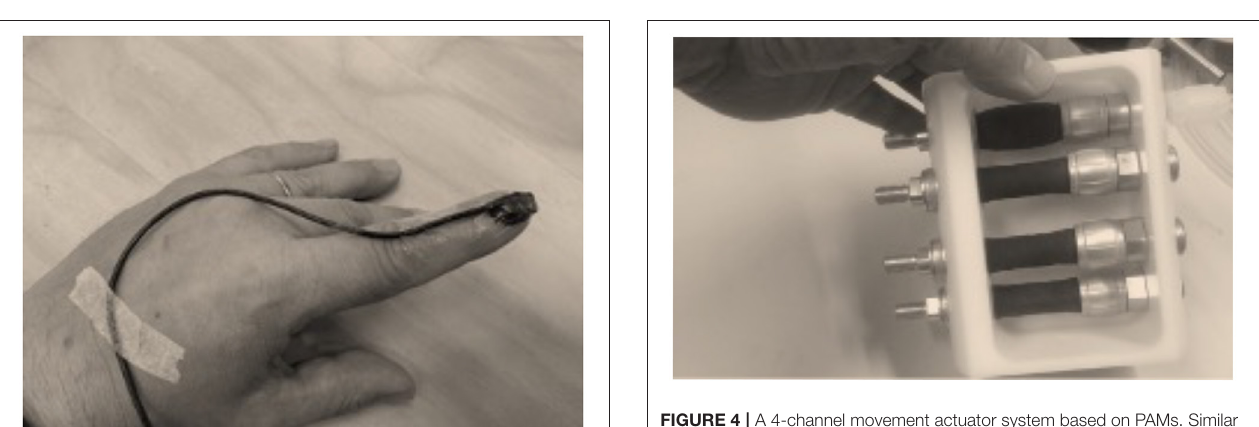
FIGURE 4 | A 4-channel movement actuator system based on PAMs. Similar PAMs were used in studies using computer-controlled PAM stimulator. Note that the uppermost artificial muscle is contracting due to compressed air pulse applied on the muscle and the muscle is relaxed when it is depressurized. The maximum movement range of the muscle in the figure is about 10mm, that is, 20% of the original